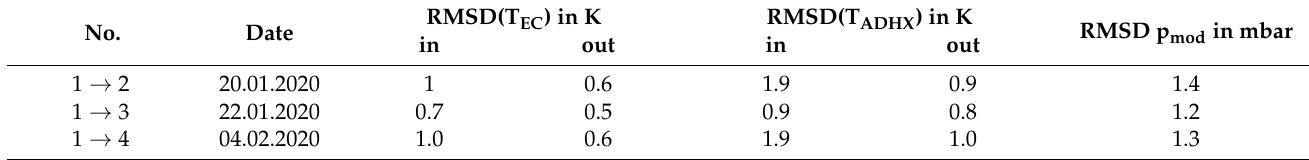
Table 7. Reproducibility of dynamic data in terms of root mean square deviation